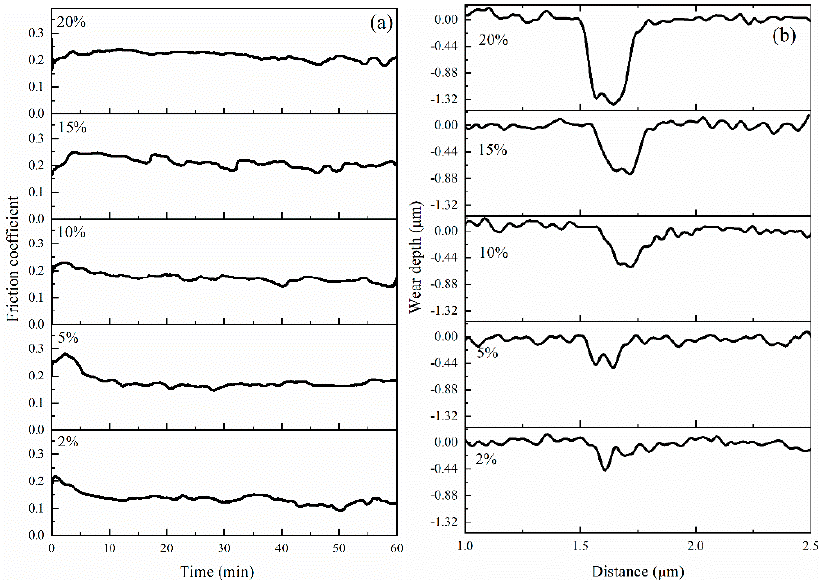
Figure 11. ( a ) Friction coefficient of the Cr-DLC films deposited at different set values and ( b ) corresponding surface profiles of the wear tracks after test.